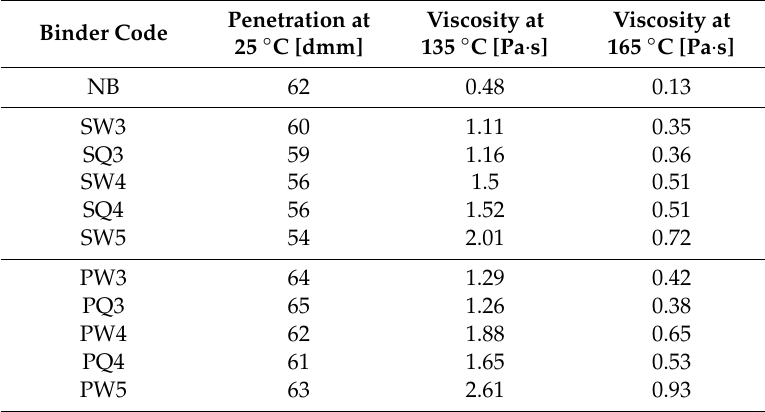
Table 4. Results of penetration and viscosity